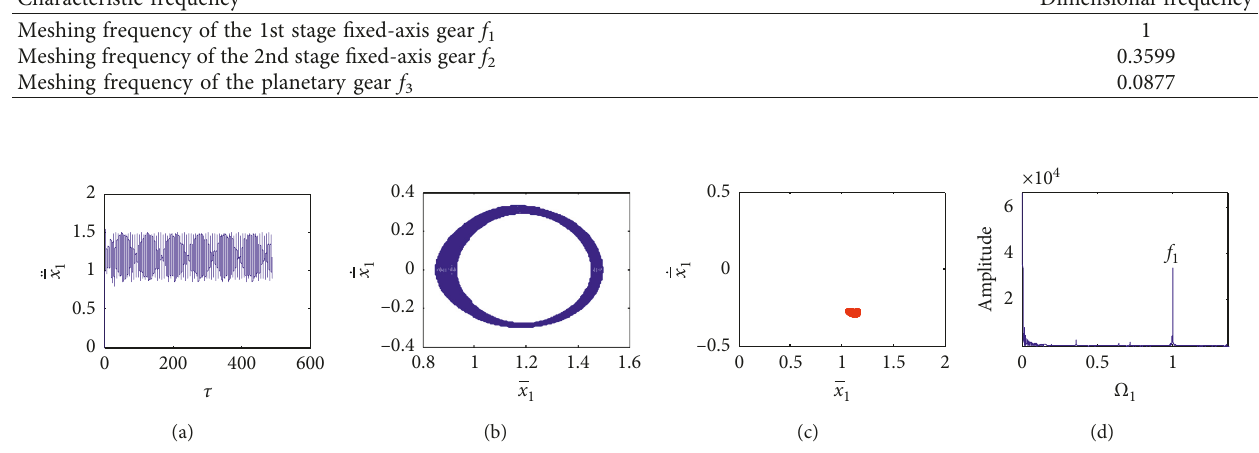
Figure 3: Vibration characteristics when Ω � 0.3: (a) time domain, (b) phase diagram, (c) Poincar ´ e section, and (d) frequency domain. 1